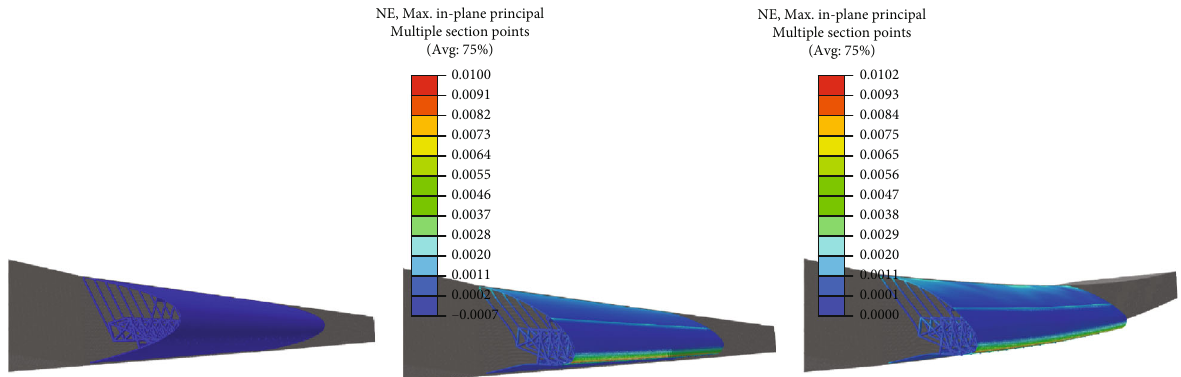
Figure 25: Assessment of the interaction between droop nose device and wing-box.